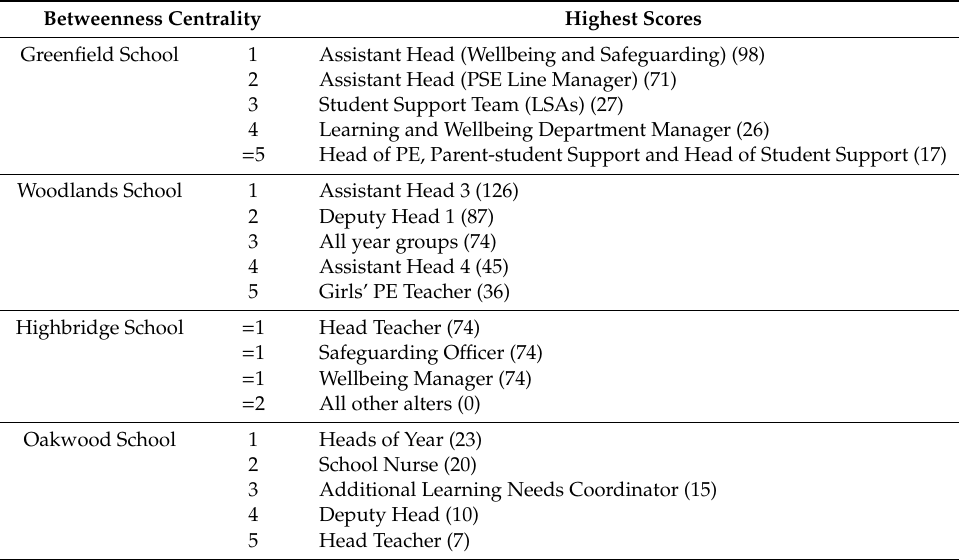
Table 4. Top five scores for betweenness centrality for health and wellbeing-related ego networks within each case study (excluding